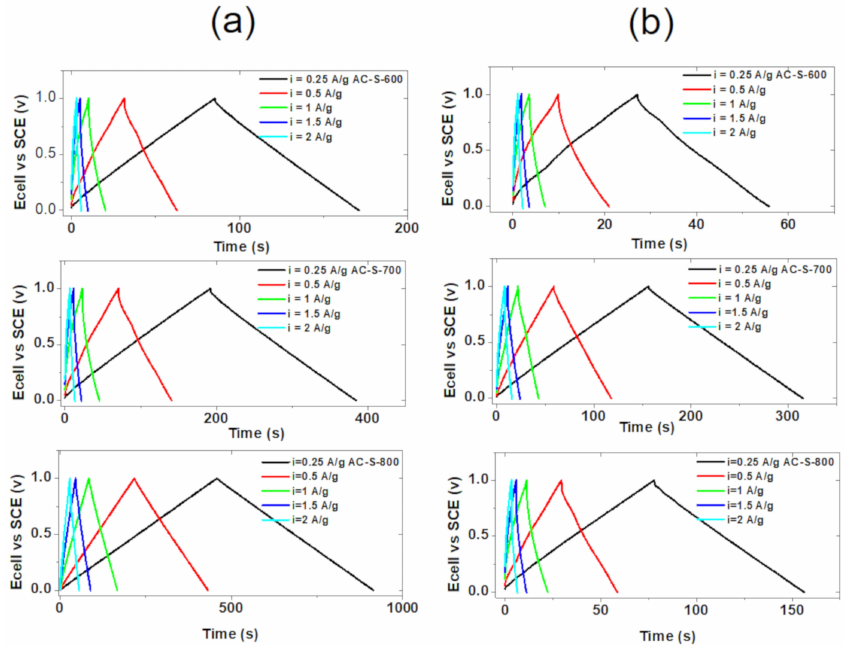
Figure 8. Galvanostatic charge-discharge (GCD) curves for AC-S-600, AC-S-700 and AC-S-800 electrodes materials at di ff erent current densities with ( a ) 6 M KOH and ( b ) 1 M Na 2 SO 4 as